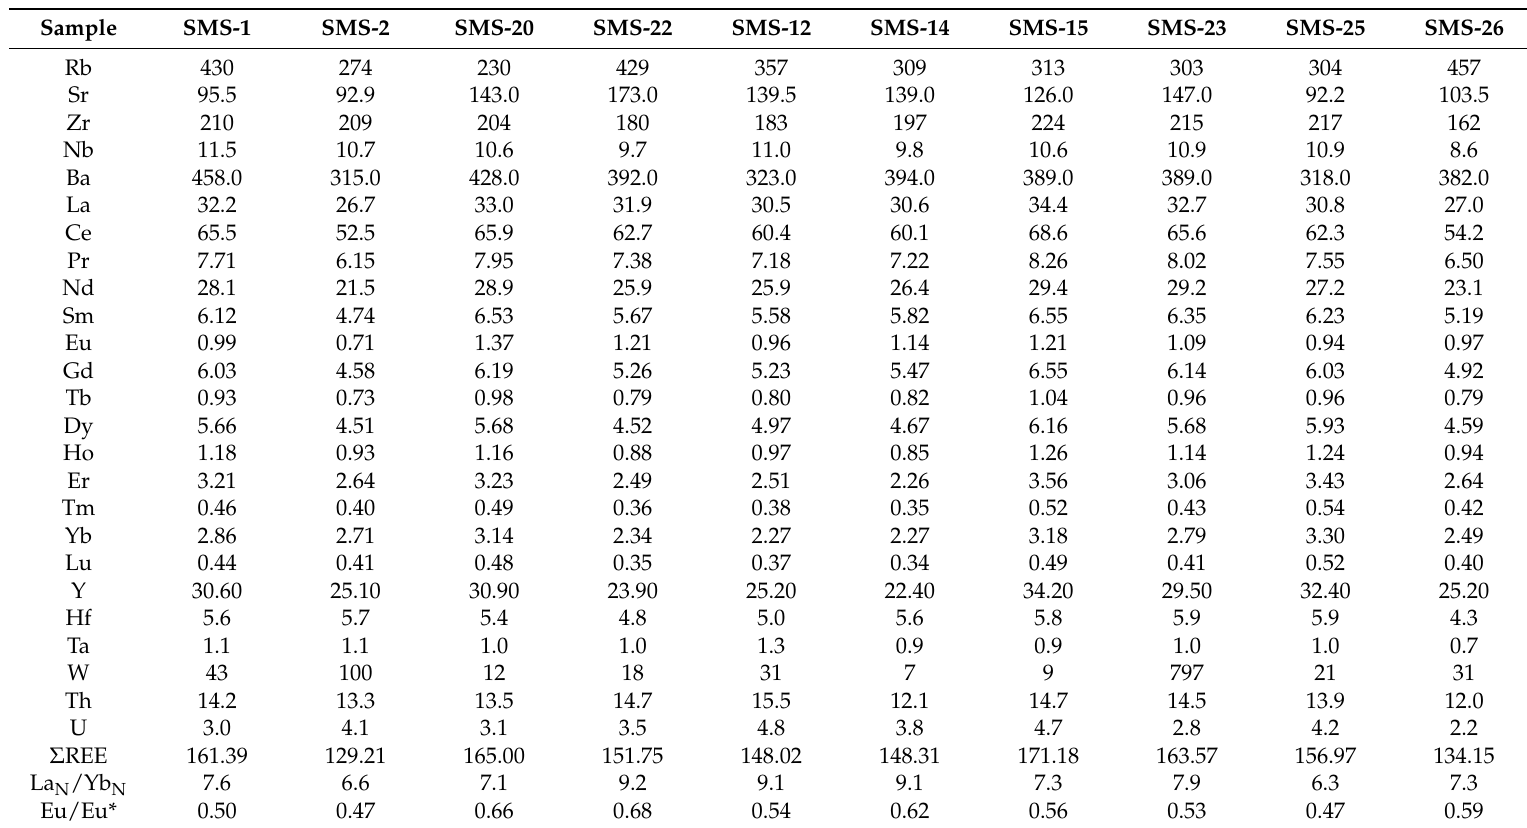
Table 2. Trace element contents of the Shimensi granodiorite